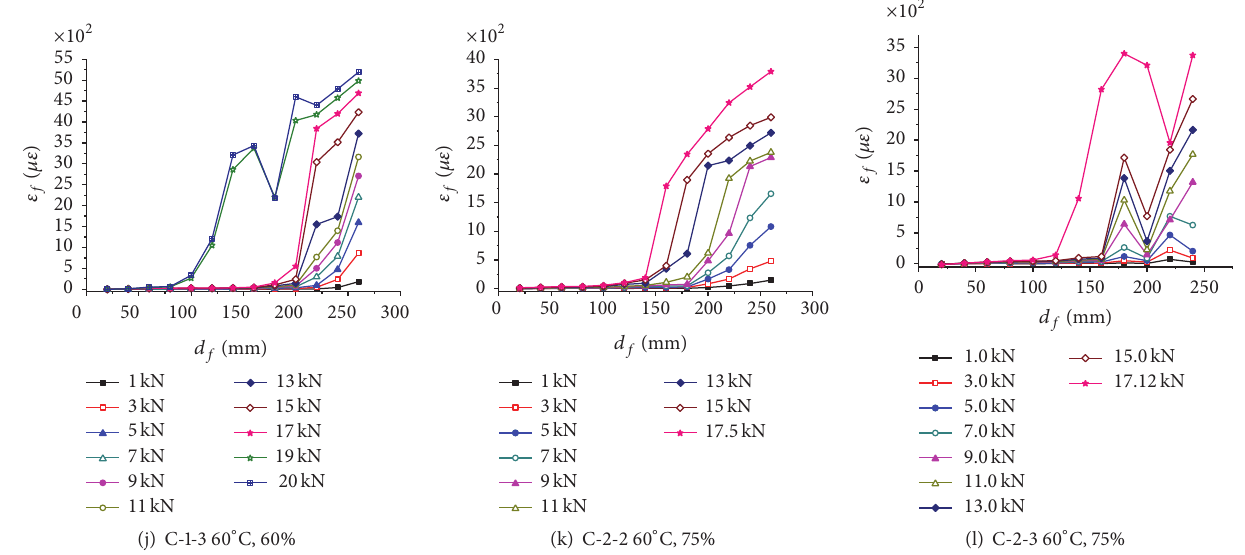
Figure 13: Strain distributions for groups A to C